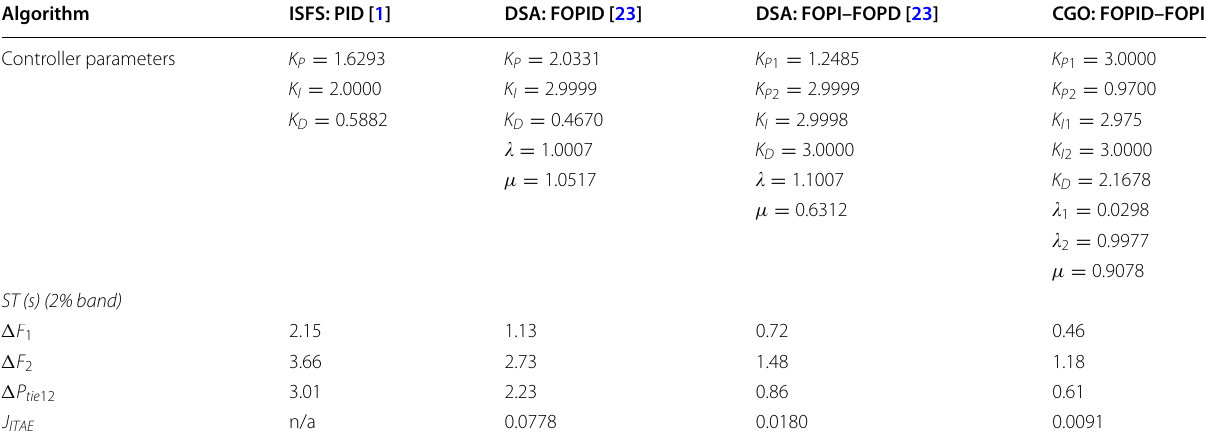
results of Test-system-1 ITAE